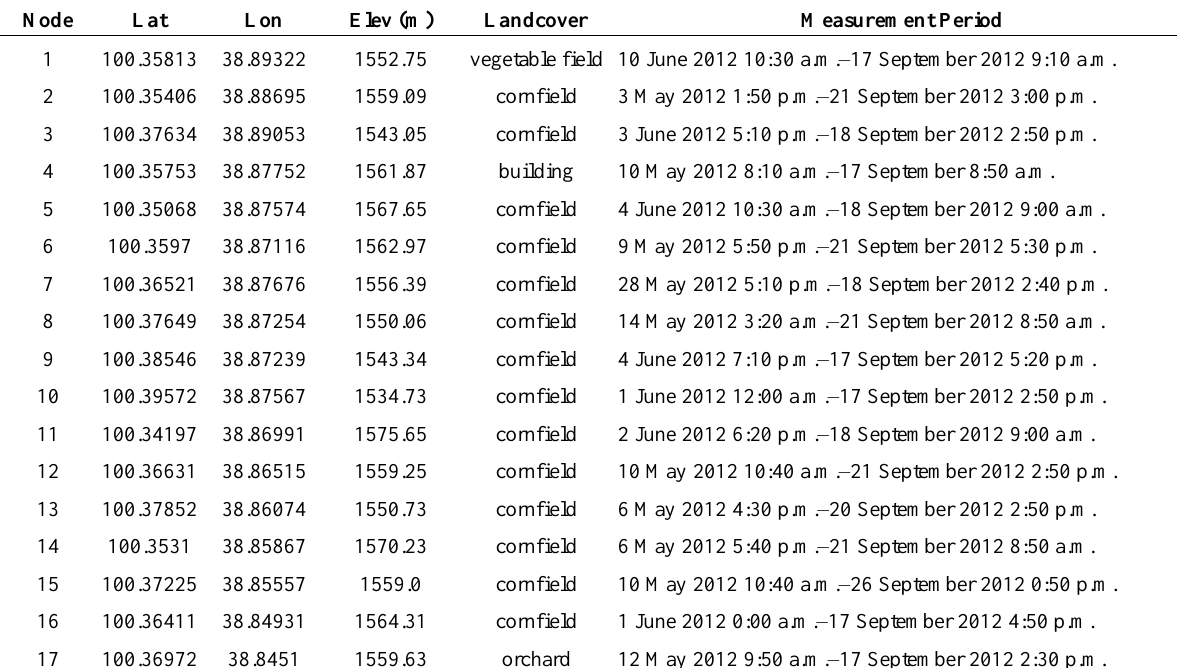
Table 1. Description of the WSN